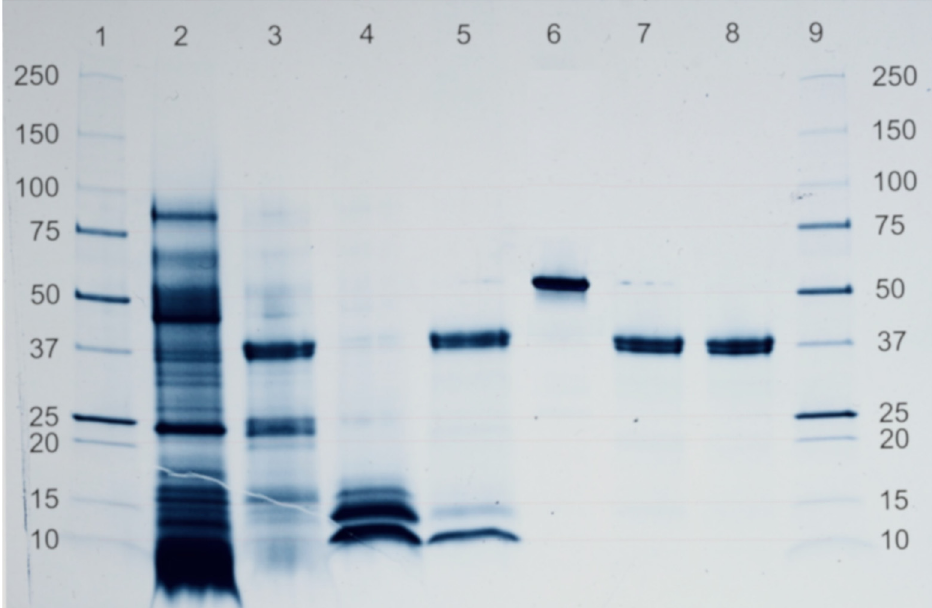
Figure 4. Electrophoretic profile and protein digestibility of GL and GZ . 1 and 9: Protein patterns.